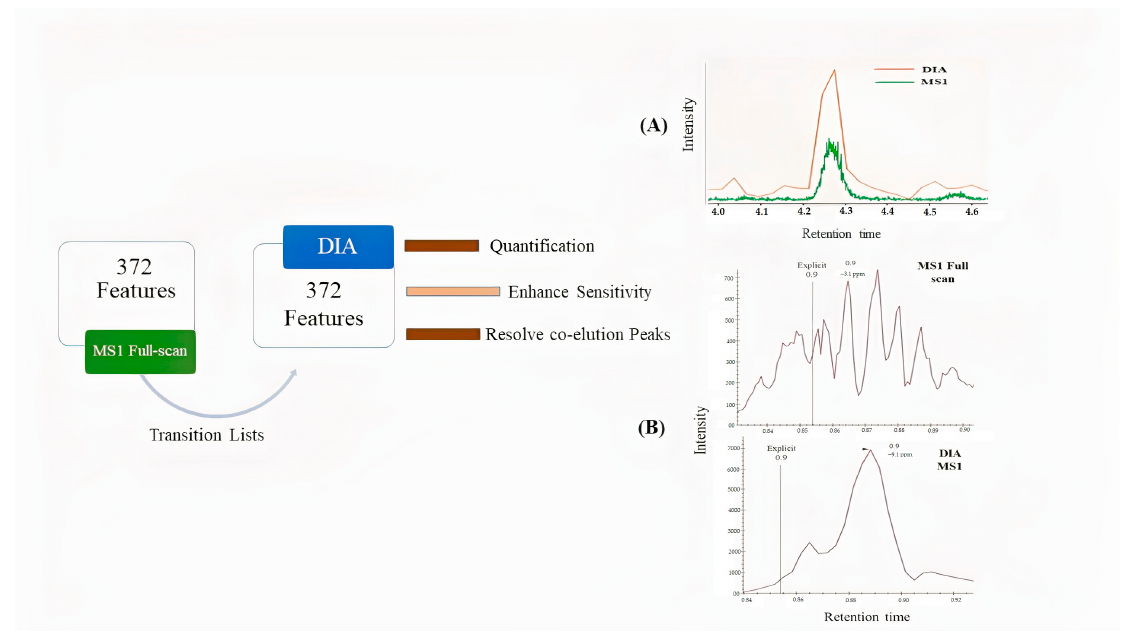
Figure 4. In total, 372 features of the QC sample were annotated using MS1 mode in MS-DIAL, then compared using the DIA mode in Skyline with the transition list (1-naphthylamine, a serum metabolite taken as an example) that resulted in ( A ) enhanced sensitivity in DIA and ( B ) resolved co-elution of peaks and quantitative analysis on the MS1 level in DIA mode.